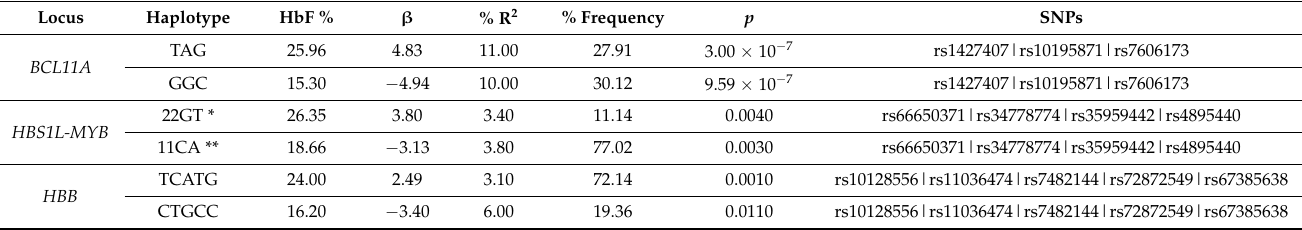
Table 2. Haplotype analysis of selected SNPs located in the 3 principal loci BCL11A, HBS1L-MYB and HBB that are associated with HbF levels in single marker analysis of Kuwaiti patients with